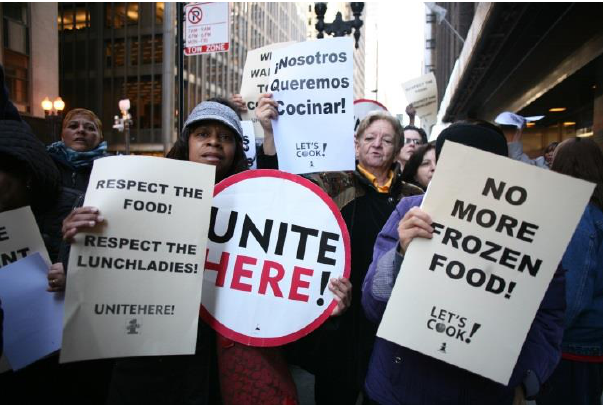
FIGURE 2: UNITE HERE LOCAL 1 PROTEST IN CHICAGO. COURTESY OF KYLE